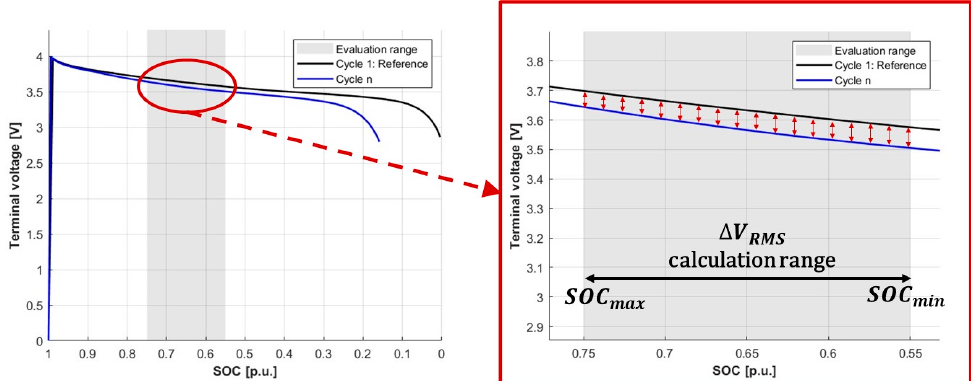
Figure 1. Instantaneous terminal cell voltage [V] vs. SOC [p.u.] during the first discharge cycle (reference cycle) and the n -th cycle. Calculation of the ∆ V RMS indicator between the first discharge cycle and the n -th (generic) cycle.